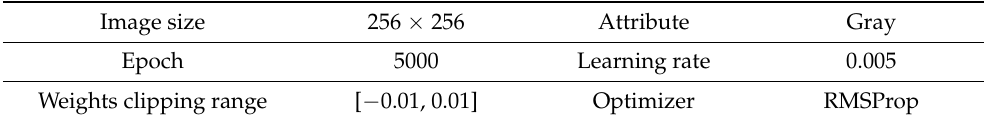
Table 3. The WGAN model parameters.